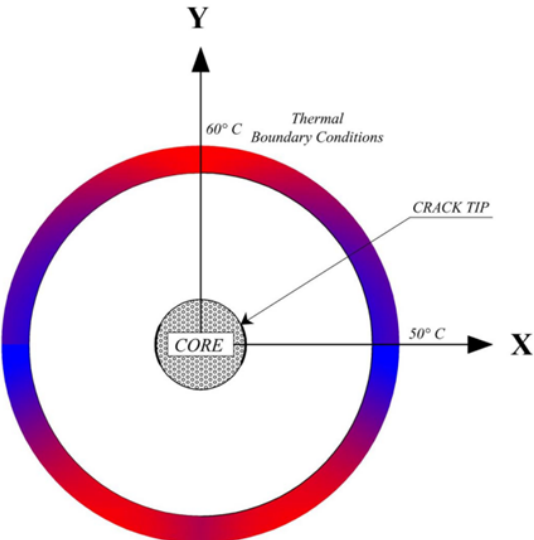
Figure 1: Applied forces and Thermal conditions on the